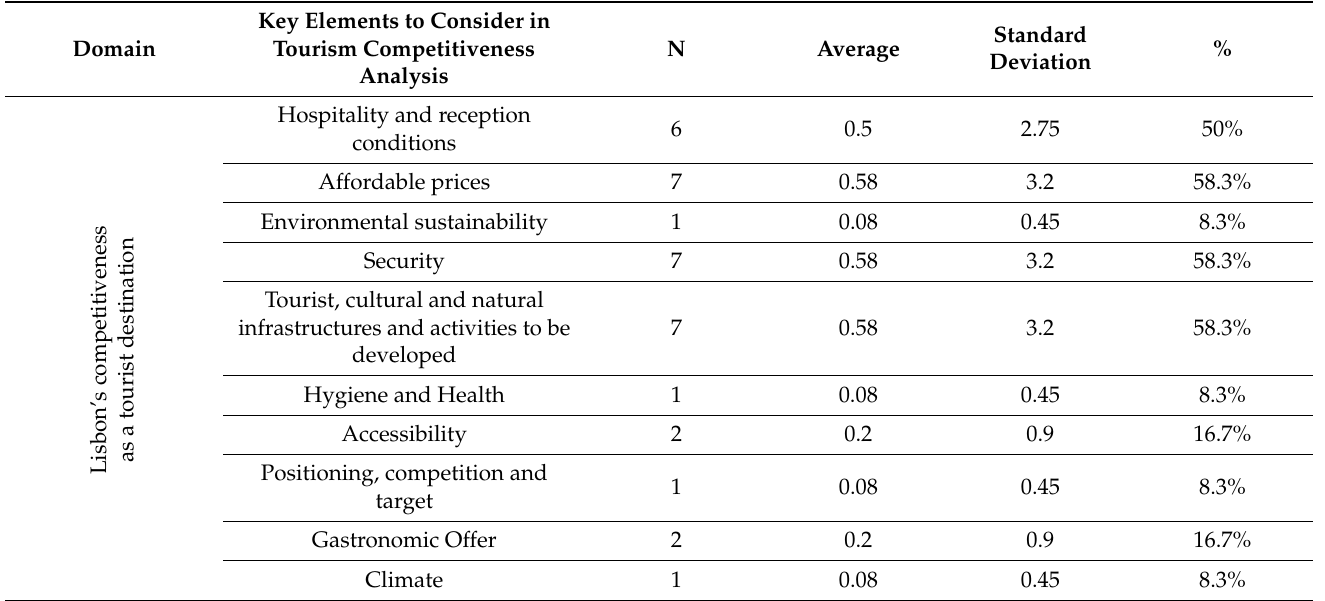
Table 7. Results of the first round of interviews—Domain, Key elements to consider in tourism competitiveness analysis. Source: Elaborated by the